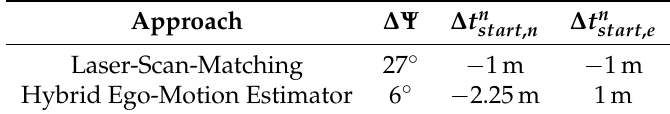
Table 5. Rotation and translation of trajectories so that the indoor constraints are